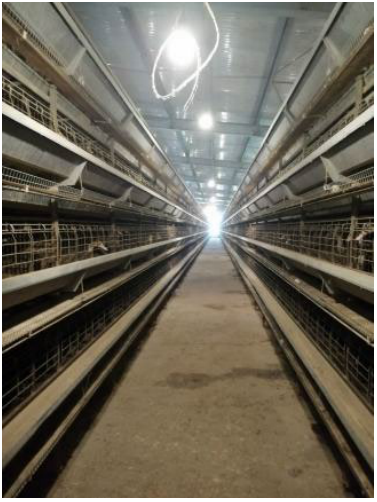
Figure 2. Scene map of the experiment site.